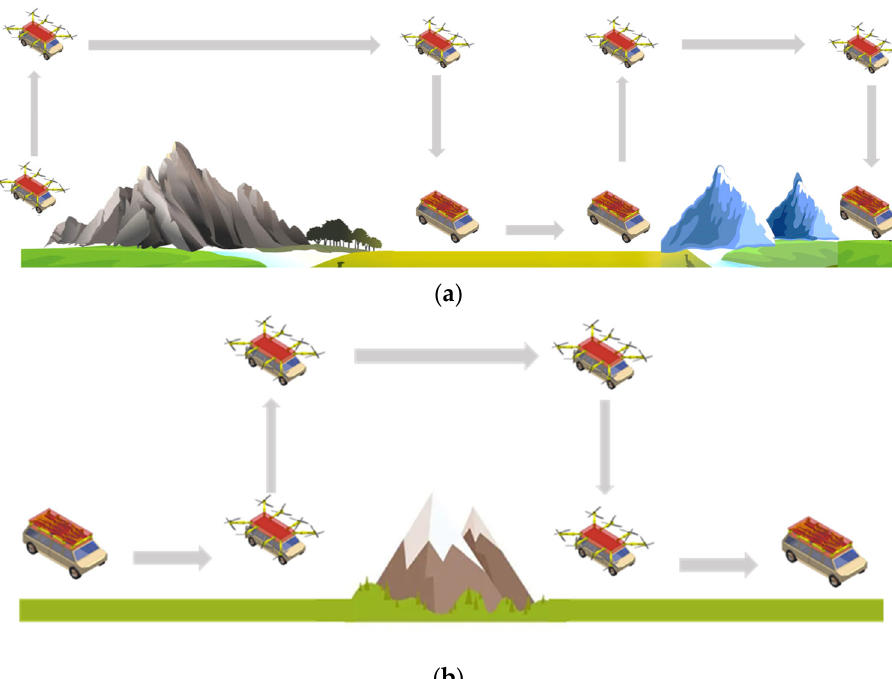
Figure 9. The HEAGV mission profile in flight and on ground. ( a ) Driving cycle A. ( b ) Driving cycle B.